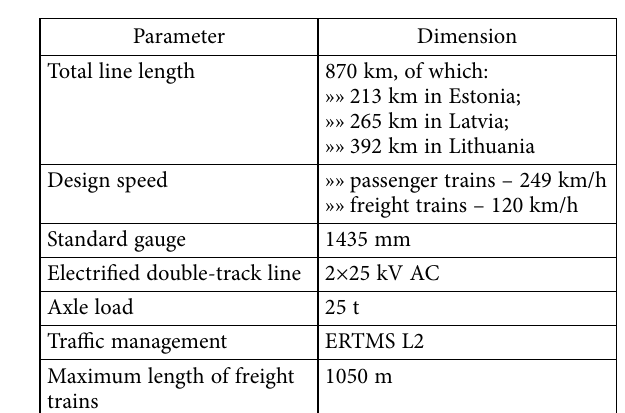
Table 5. Technical parameters of Rail Baltica (RailBaltica.org